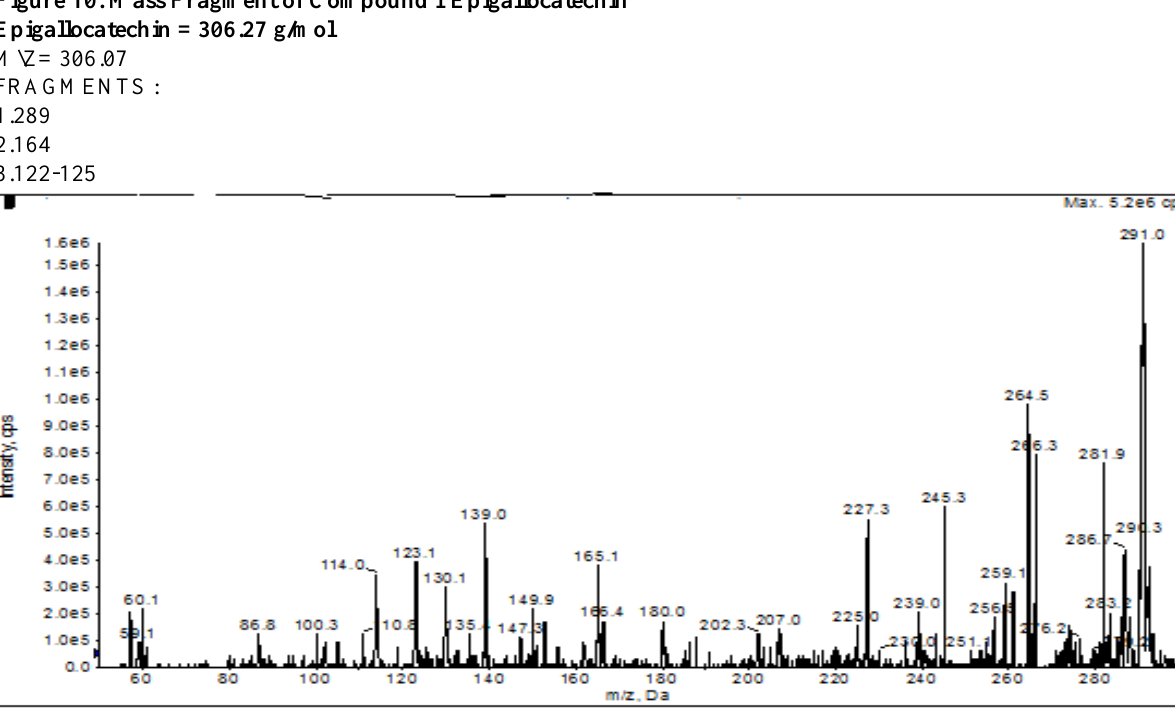
Figure 11. LC-MSMS of Compound